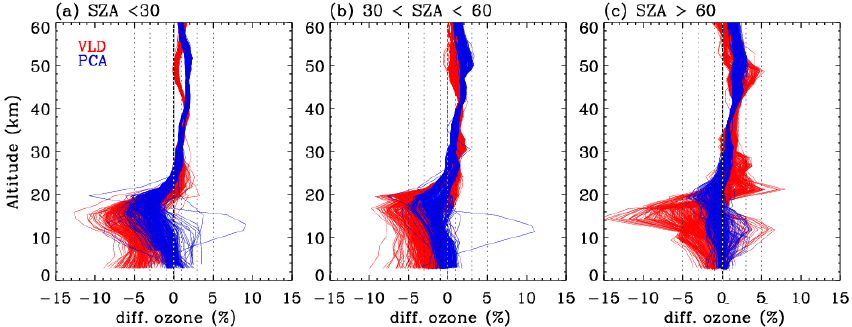
Figure 10. Same as Fig. 9 but for individual differences. VLD and PCA represent v1 and v2 forward model configurations, respectively.